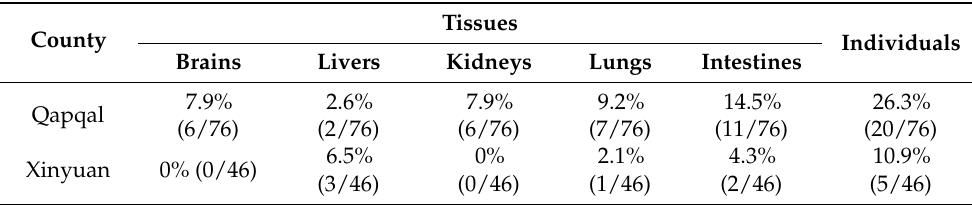
Table 1. RT-PCR detection of MRV in bat